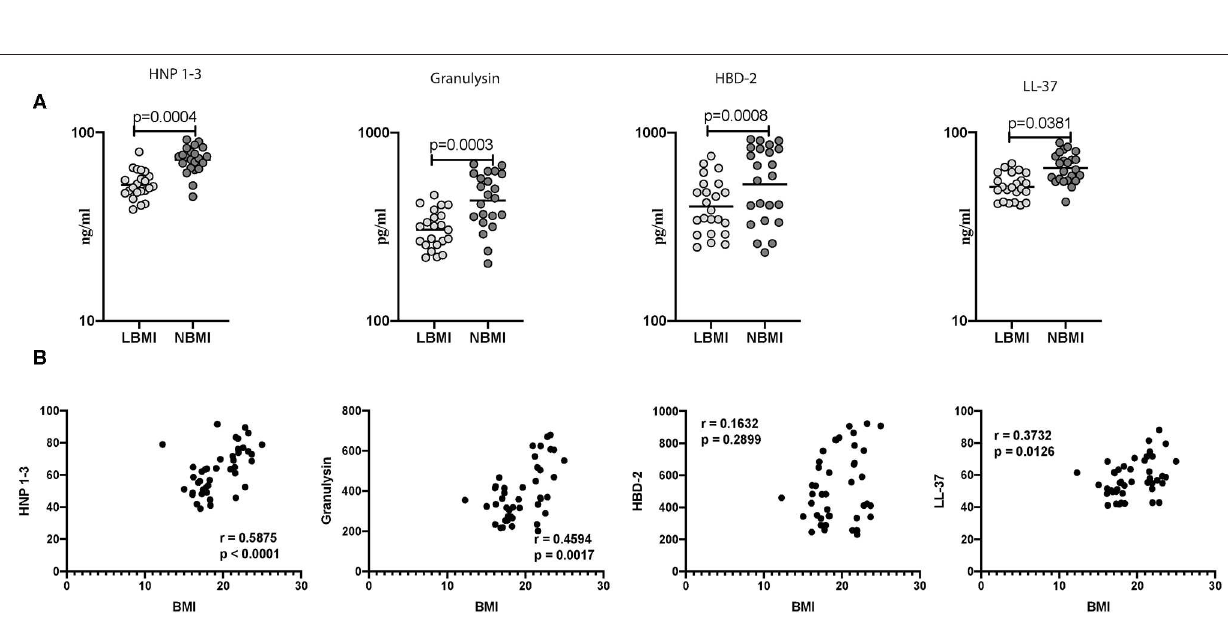
Frontiers in Cellular and Infection Microbiology | www.frontiersin.org